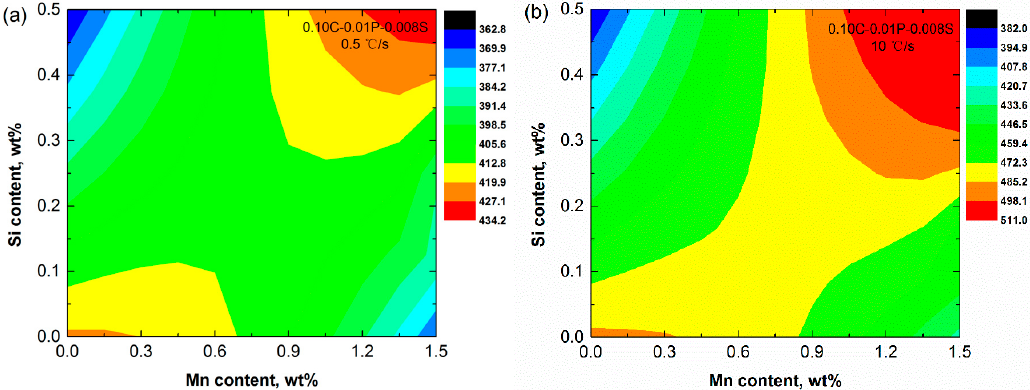
Figure 6. Crack susceptibility map of peritectic steels with varying Mn and Si at cooling rates of: ( a ) 0.5  C/s, ( b ) 10 